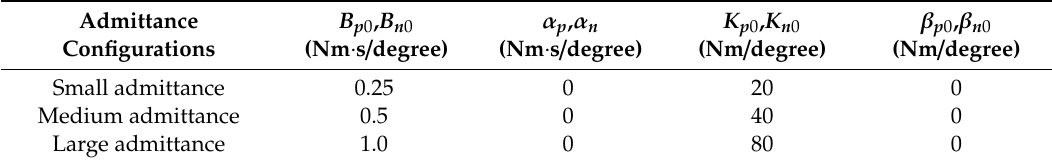
Table 1. Three di ff erent admittance